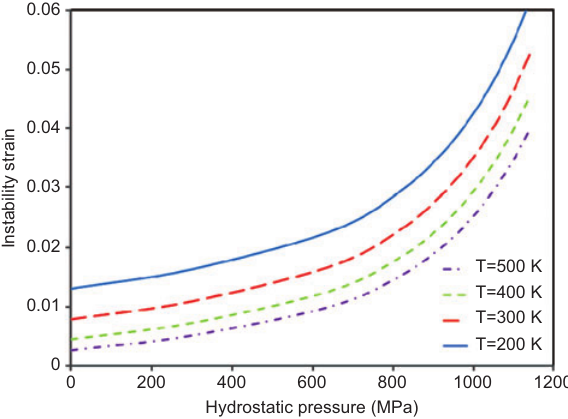
Figure 21 Instability strain vs. hydrostatic pressure of CR-1018